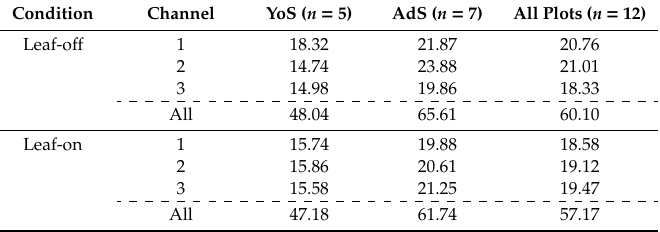
Table 2. Average point density (points / m 2 ) for all channels from all laser returns among young seedling stands (YoS), and advanced seedling stands (AdS) plots in leaf-o ff and leaf-on data.